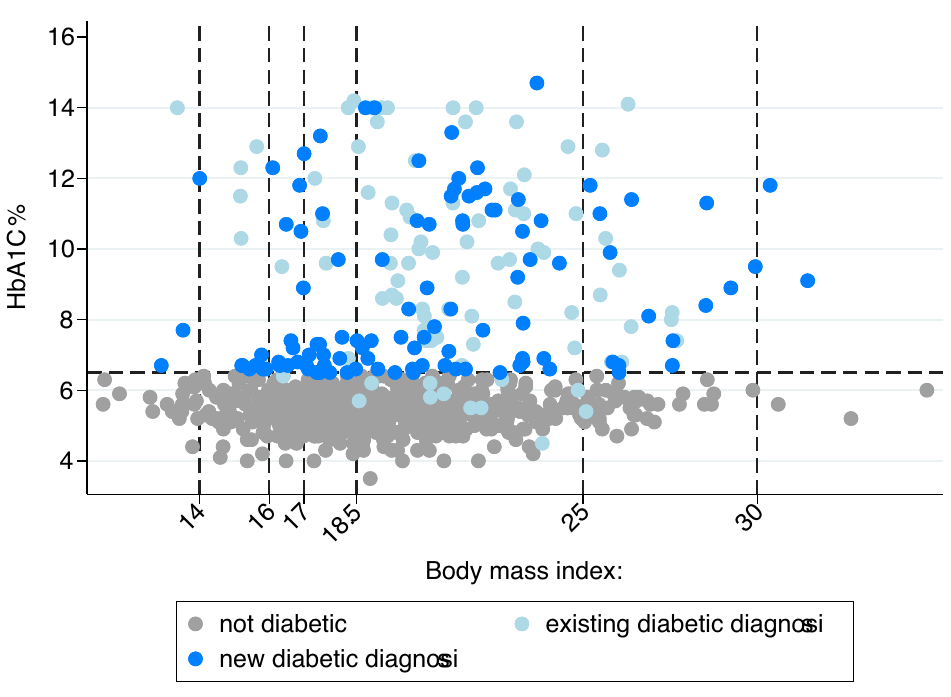
Fig 4. HbA1c by BMI for new and previous diabetes diagnoses at start of TB treatment. Footnotes: y-axis: 6.5% cut-off to determine diabetes status. x-axis: BMI cut offs indicate WHO cut-offs of nutritional status; < 14 = very severe thinness, < 16 severe thinness, < 17 = moderate thinness, < 18.5 mild thinness, < 25 normal, < 30 overweight, � 30 obese.